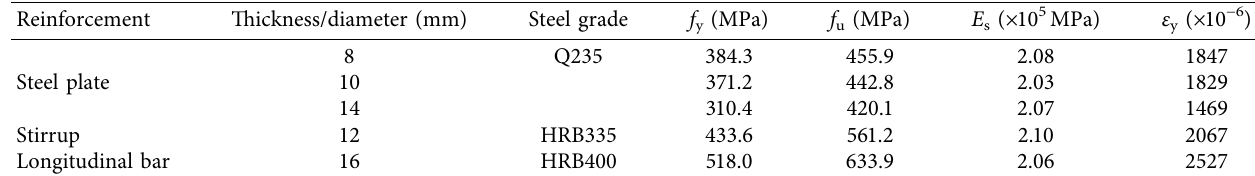
Table 2: Material properties.